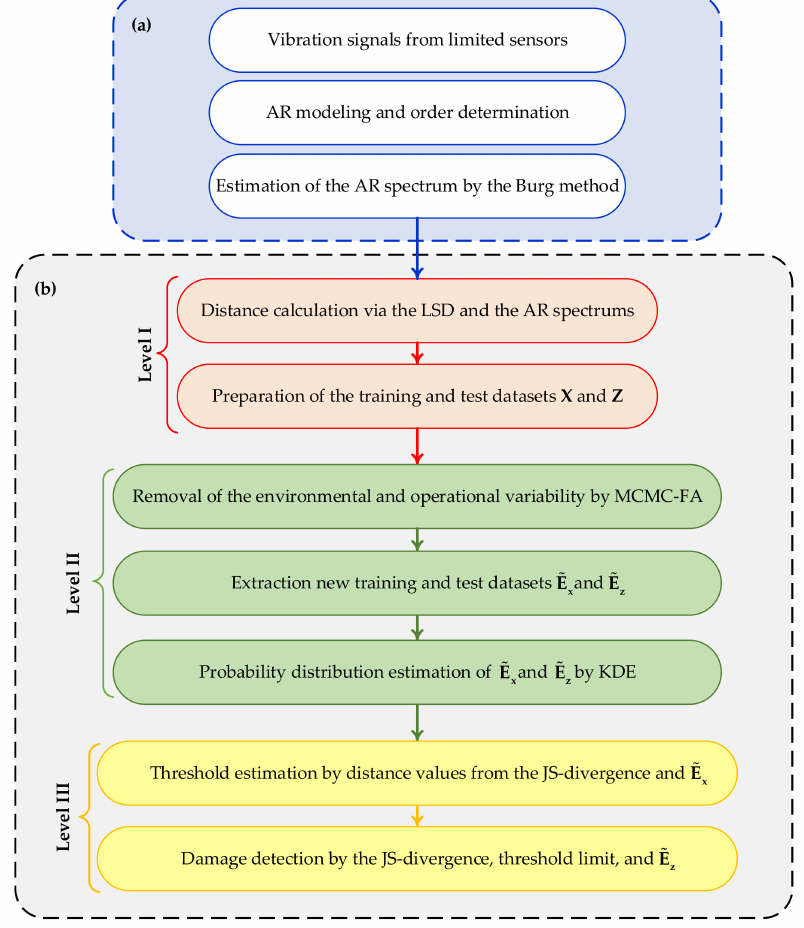
Figure 1. Flowchart of the proposed method: ( a ) feature extraction, ( b ) and multi-level machine learning